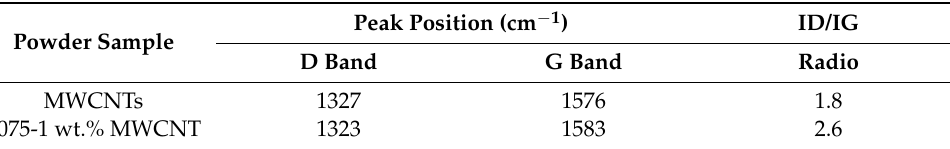
Table 2. Raman spectra characteristics for as-received MWCNTs and 7075-1 wt.% MWCNT composite after 4 h